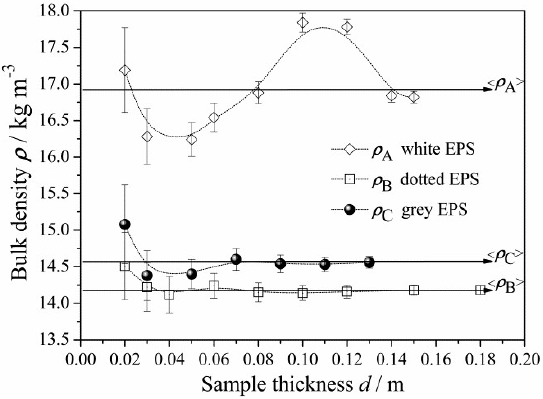
Figure 3. The measured bulk density ρ versus the panel thickness d for the EPS A, B, and C products. The error bars correspond to the expanded uncertainties, U ( ρ ). The horizontal arrows indicate the levels of the average density < ρ > values (see Table 2). Table 2. Data concerning density measurements of the materials expanded polystyrene (EPS) A, B, and C.